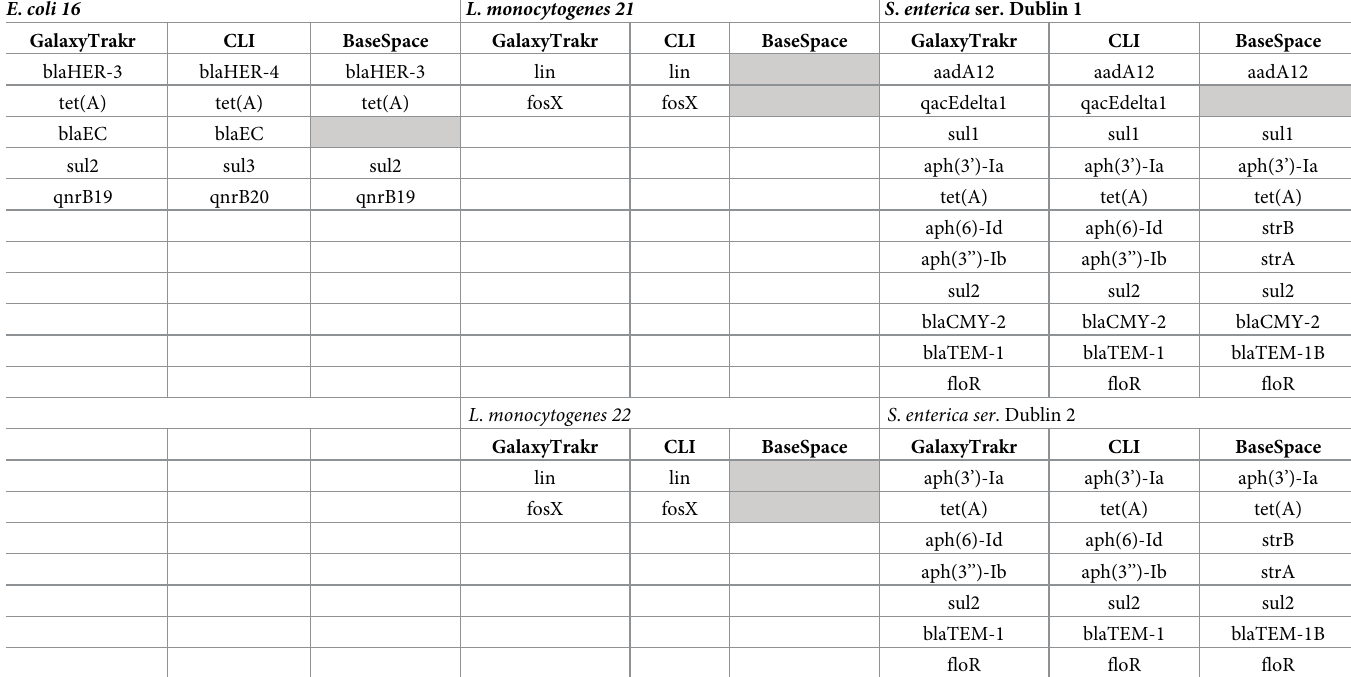
Table 5. Antimicrobial resistance genetic profile identified by user-friendly platforms (GalaxyTrakr and BaseSpace), and an inhouse pipeline in the command line interface (CLI). E . coli 16 L . monocytogenes